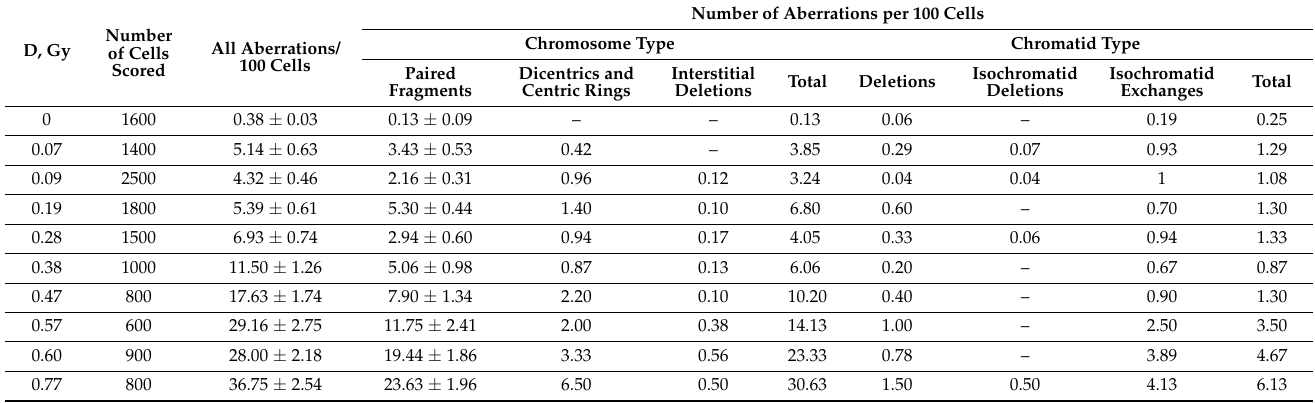
Table A4. Frequencies of chromosome aberrations induced in CHO-K1 cells by low doses of 12 C ions at Bragg curve